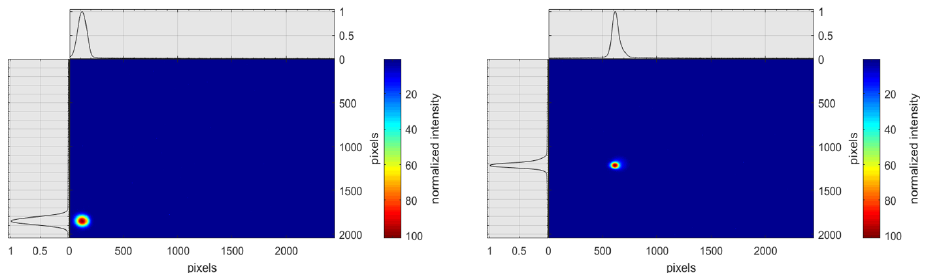
Figure 11. Comparison of the beam position on the first screen before ( left ) and after ( right ) the correction of the solenoid position in the horizontal plane. All other conditions (laser, RF settings) are identical.